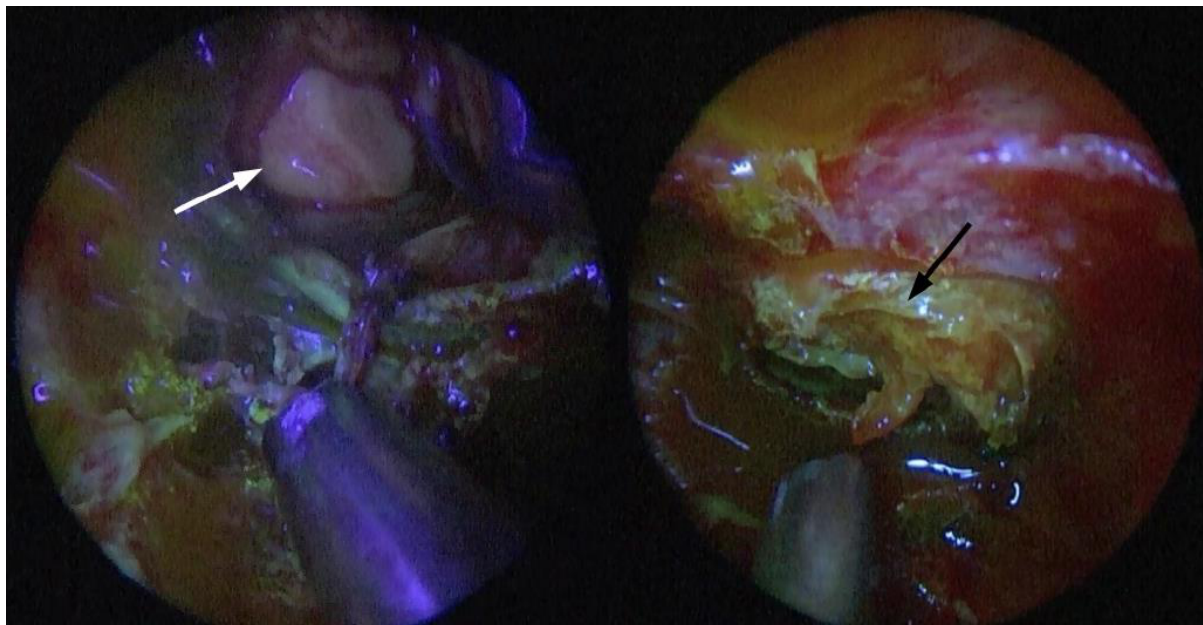
Figure 4. Endoscopic fluorescein-filtered vision of the sellar region; intradural stage, after adenoma isolation from normal parenchyma: non-enhancing adenoma (white arrow) and vividly enhancing pituitary parenchyma (black arrow).